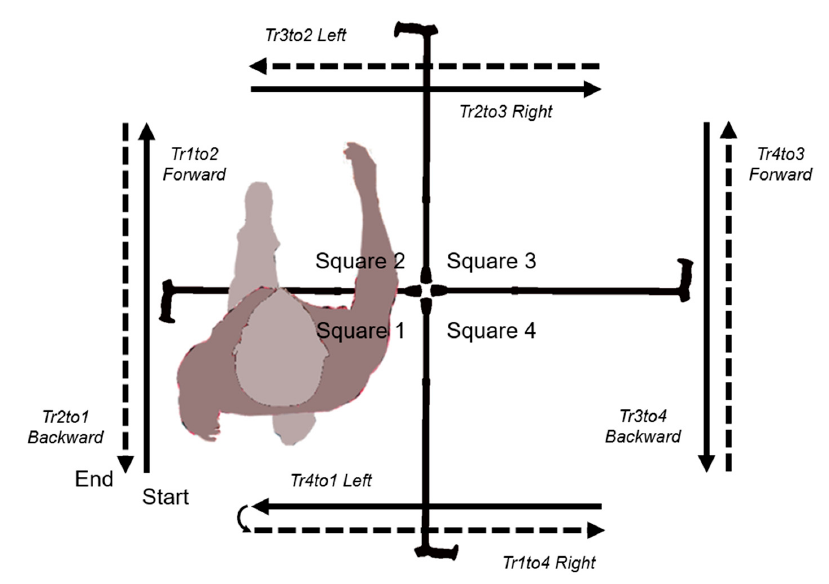
Figure 1. Sequence scheme for the Four Square Step Test.